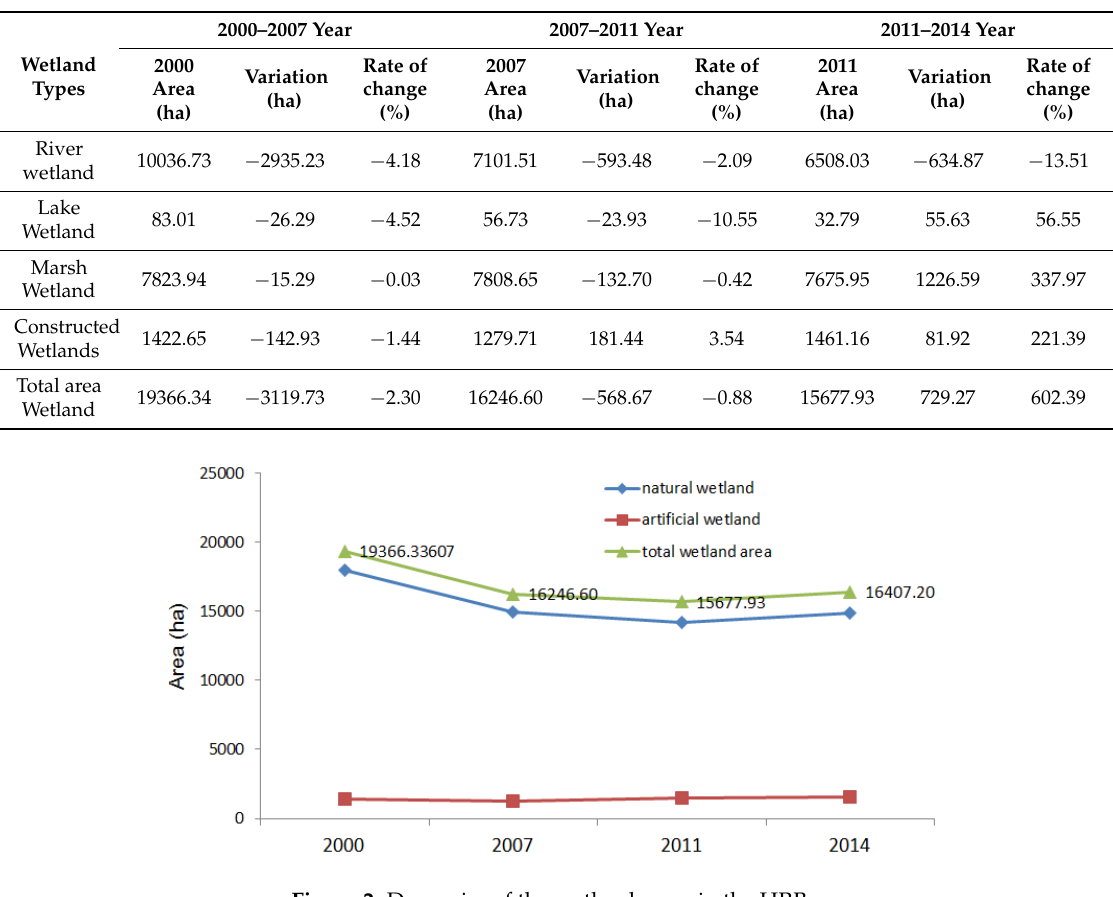
Figure 2. Dynamics of the wetland areas in the HRB.